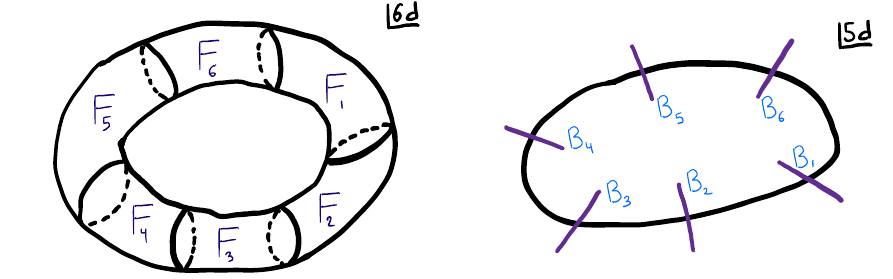
Figure 1 . Compacti(cid:12)cation on a torus in six dimensions with (cid:13)ux F for the global symmetry is constructed as a combination of blocks. Each block is associated with a tube and (cid:13)ux F j such that P F j = F . The blocks are obtained by (cid:12)rst going to (cid:12)ve dimensions, considering then interfaces B j , and then compactifying on an additional circle. This provides a systematic way to construct